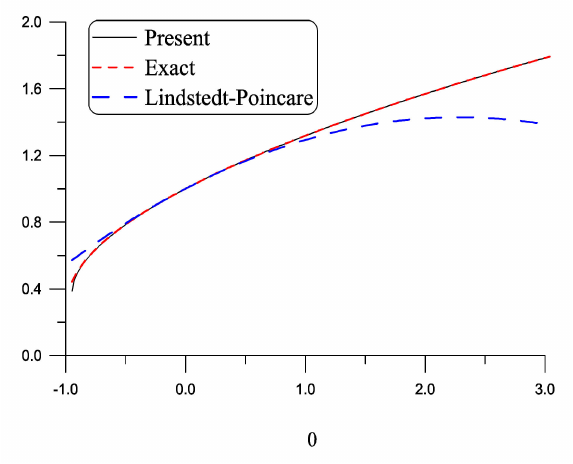
Figure 1. For the Duffing equation comparing the frequencies curves with respect to the nonlinear spring constant ε 0 from the soft one with ε 0 < 0 to the hard one with ε 0 > 0. The curve obtained by the present method coincides with the exact one, while the one obtained by the Lindstedt-Poincar é method is valid only in a small range of ε 0